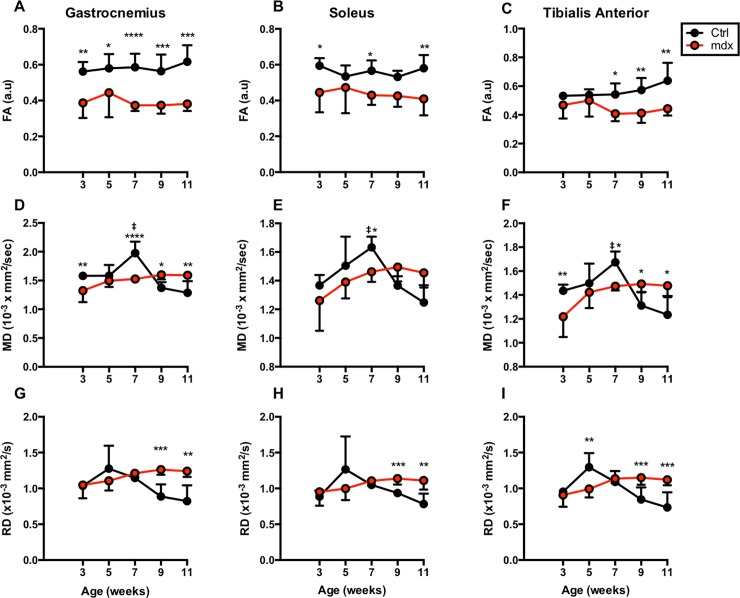
Fractional Anisotropy (FA), Mean Diffusivity (MD) and Radial Diffusivity (RD) of TA, GA, and SOL muscles.Graphs displaying average longitudinal FA, MD, and RD values for mdx4cv and control muscles. FA values from GA muscles of mdx4cv mice are significantly lower at all time points versus age-matched controls. *P ≤ 0.05, **P ≤ 0.01, ***P ≤ 0.001, and ****P ≤ 0.0001.